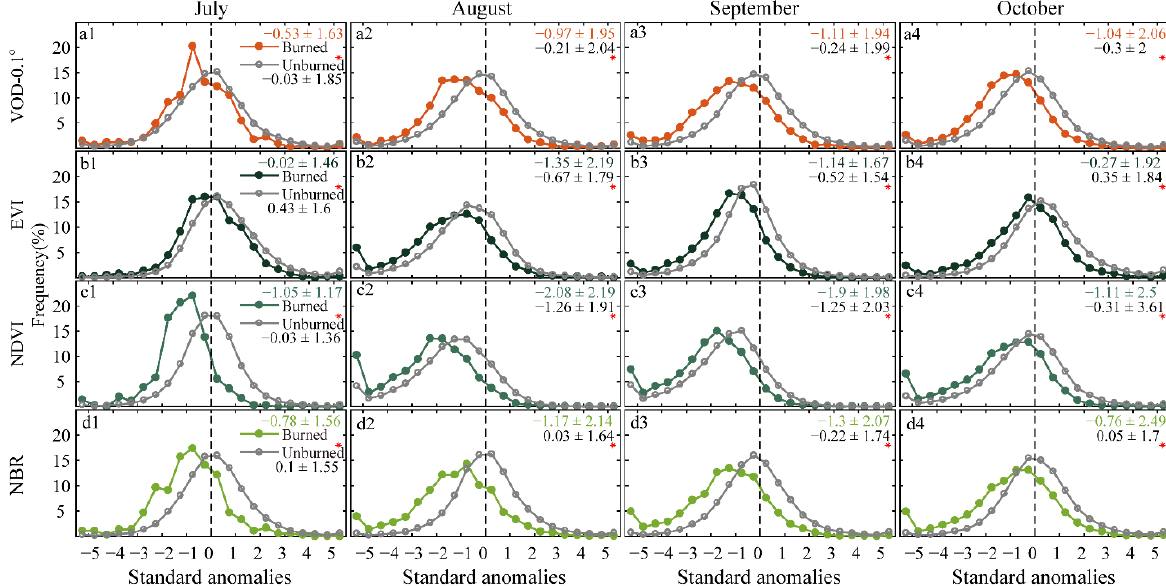
Figure 5. A comparison of standardized anomalies’ distribution between burned and unburned pixels in remote sense indices over July–October. Histograms of standardized anomalies from July to October in ( a1 – a4 ) VOD-0.1°; ( b1 – b4 ) EVI; ( c1 – c4 ) NDVI; and ( d1 – d4 ) NBR. A red asterisk indicates that the anomalies between burned and unburned pixels were significantly